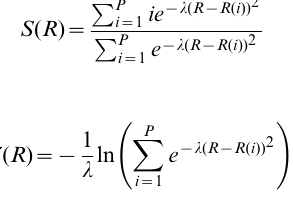
Figure S1 Effect of pH on CBAH activity. The figure is adapted from Gopal-Srivastava R, Hylemon PB (1988) Purifica- tion and characterization of bile salt hydrolase from Clostridium